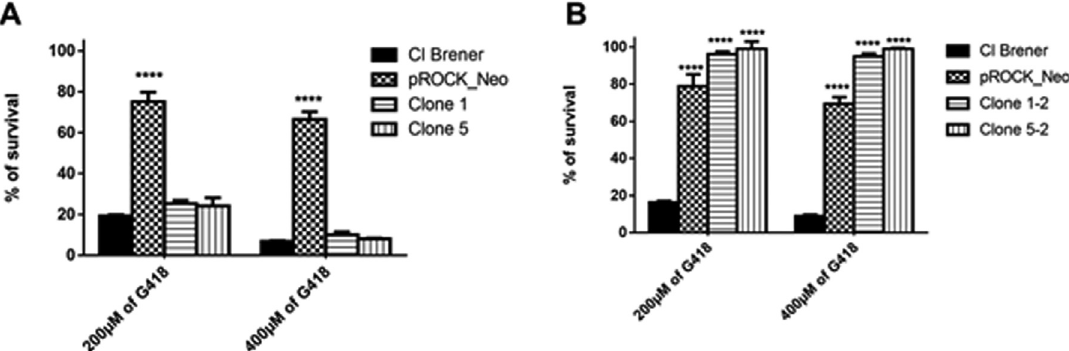
Figure 3 - Long term incubation leads to selection of T. cruz i Neostop revertant clones. T. cruzi neostop transfection, selection, genotyping, and growth rate and survival were determined as described in Materials and Methods , items 3 and 4. Panel A: Resistance of T. cruzi Neostop epimastigotes against G418 after 7 daysofcellulargrowthinliquidmedium.(B)Resistanceof T.cruzi Neostop epimastigotesagainstG418after42daysofgrowthinliquidmedium,indicating that cell duplication allows mutational events in T. cruzi . Epimastigotes harboring pROCK_Neo construct were used as positive controls for aminoglycoside resistance. Statistical analyses (One-Way ANOVA) were conducted using GraphPad Prism software v6.0. **** p < 0.001 vs.